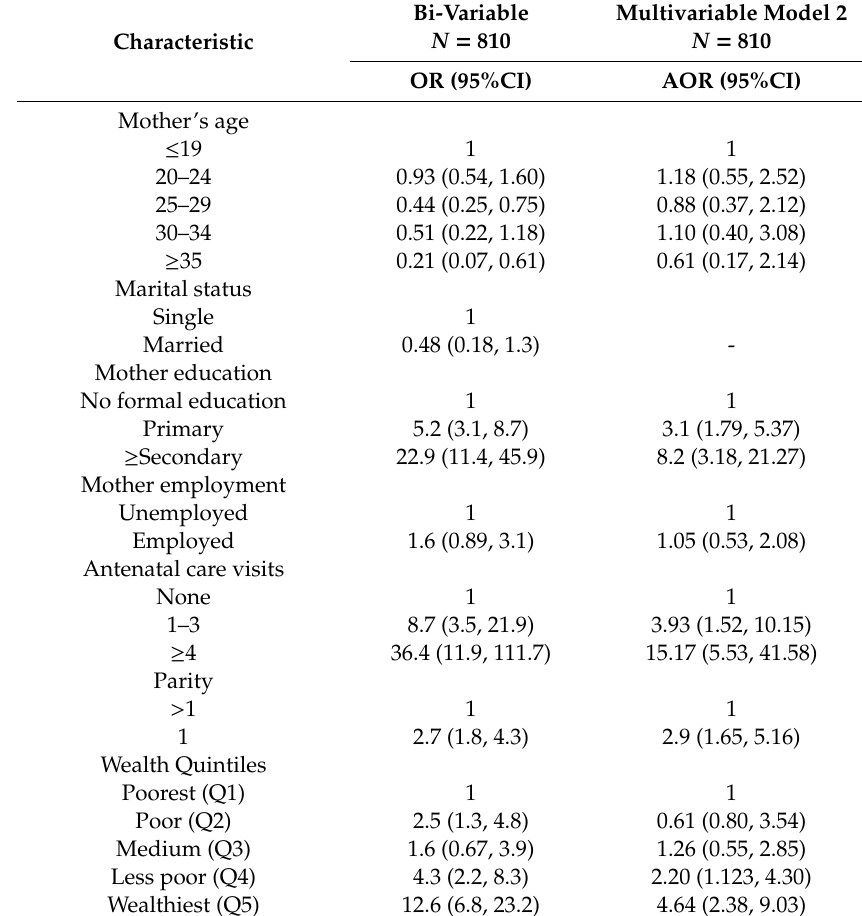
Table 3. Bi-variable and multivariable logistic regression analysis of skilled birth attendance in a community survey in Jubek State, South